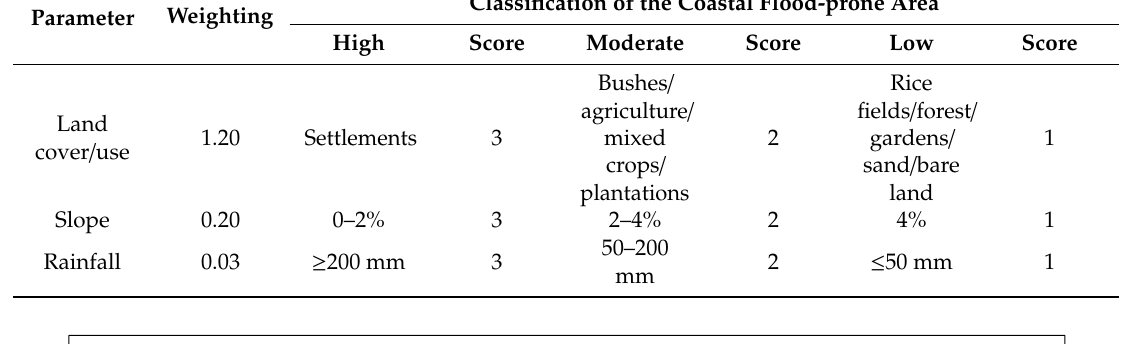
Table 4. Matrix of the MCE for the CFR-new.